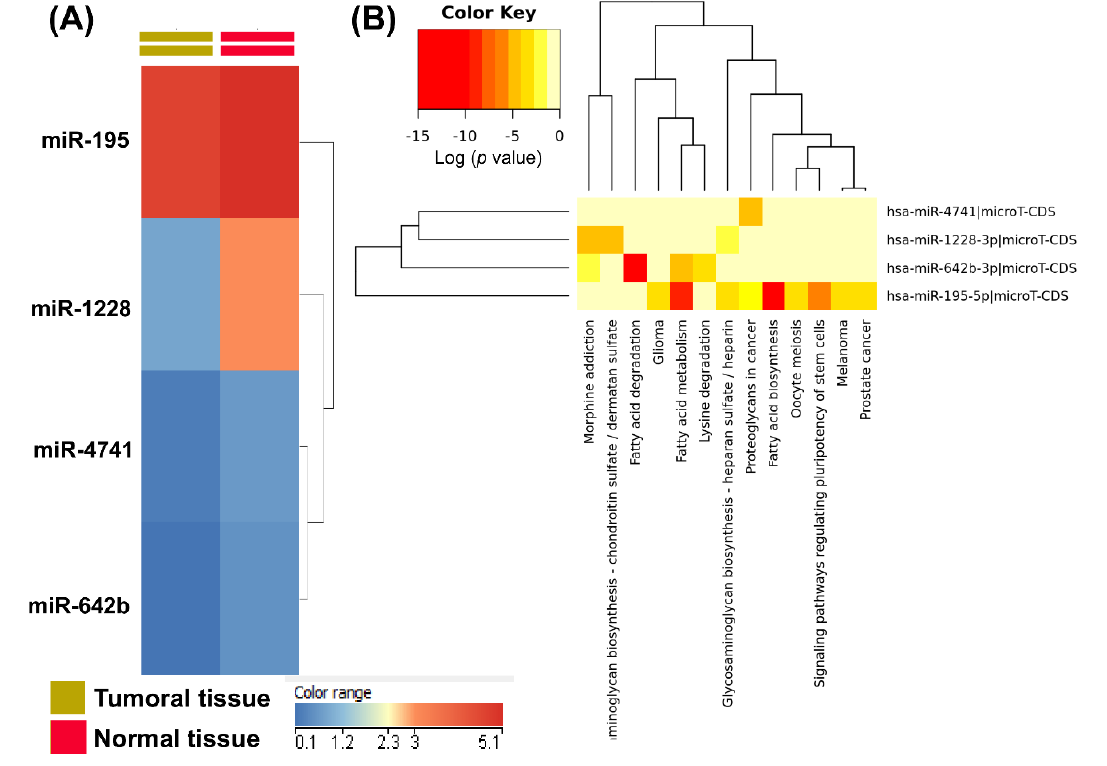
Figure 5. Common miRNA signatures for colon, rectal and colorectal cancers involved in drug resistance. ( A ) Heatmap of the four validated miRNAs. ( B ) Heatmap generated using DIANA-miRPath v3.0 (http: // snf-515788.vm.okeanos.grnet.gr), showing miRNA targets associated with biological processes related to the validated miRNAs.